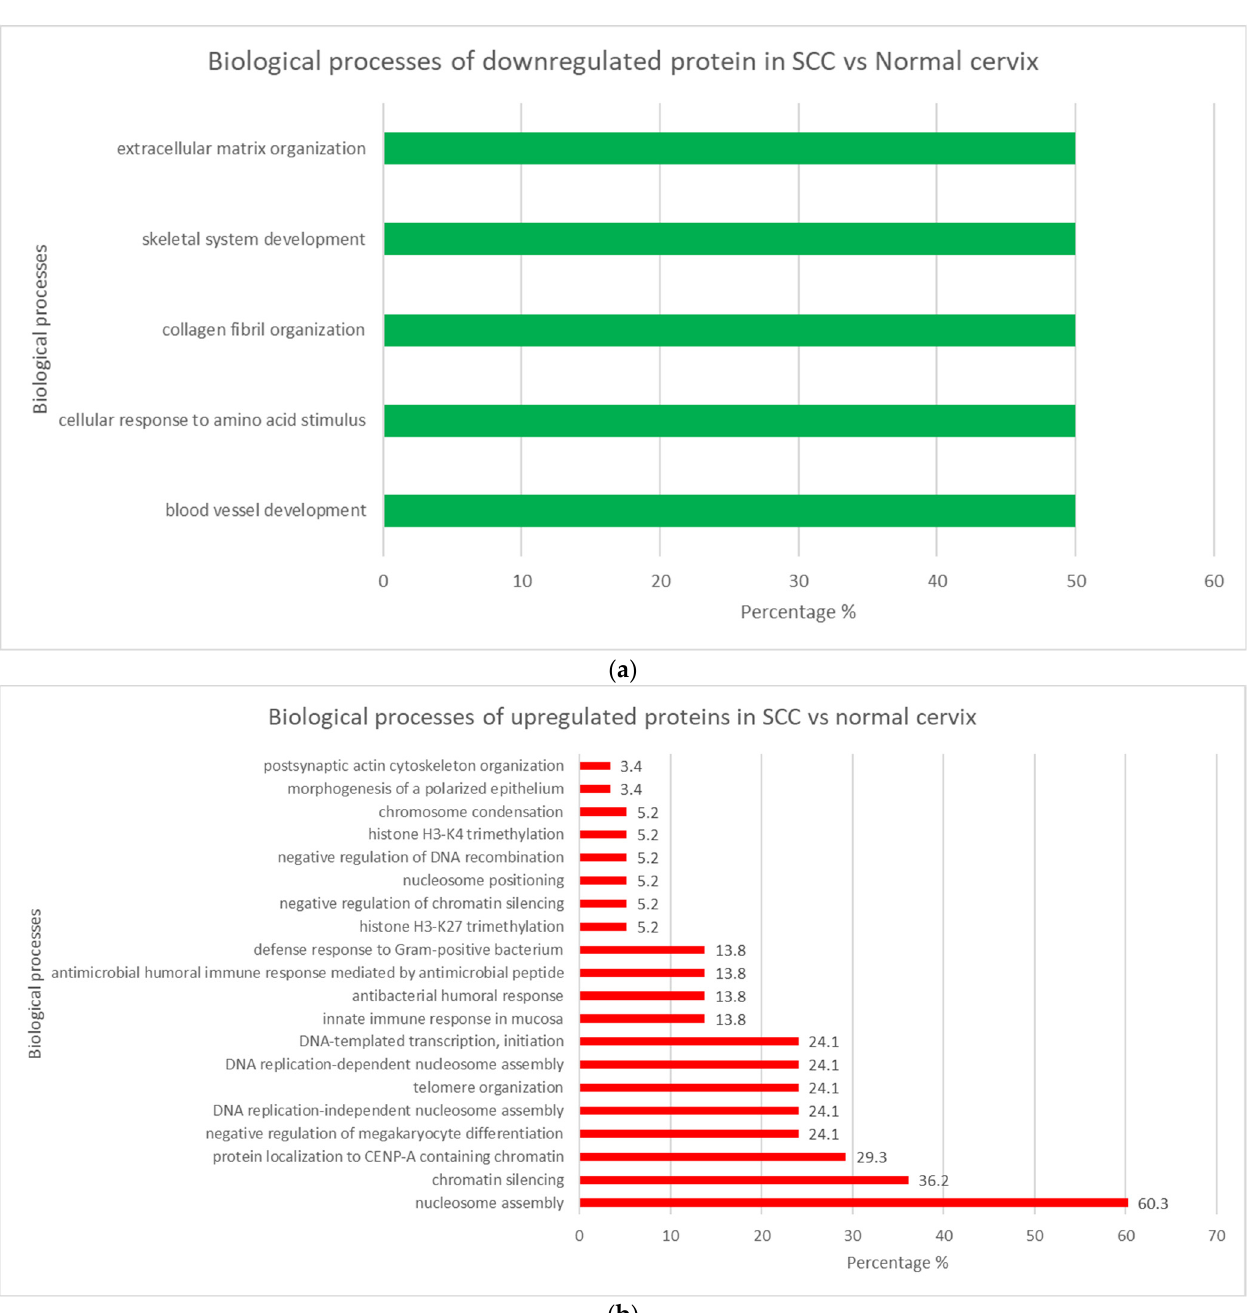
Figure 4. Classi fi cation of biological processes of ( a ) upregulated and ( b ) downregulated proteins in SCC vs. normal cervix group. The percentage re fl ects the number of proteins involved in each biological process. The gene ontology classi fi cations were generated using DAVID version 6.8 (released 19 February 2022). Table 4. Pathways involved in upregulated and downregulated proteins in SCC vs. normal cervix group using ConsensusPathDB software.